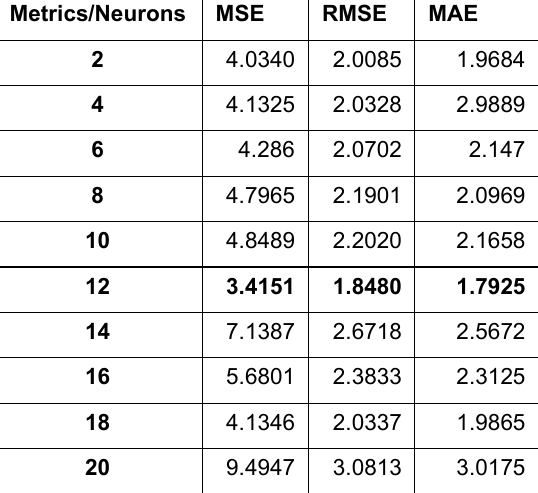
Table.6 Performance Error Metrics resulted by DE